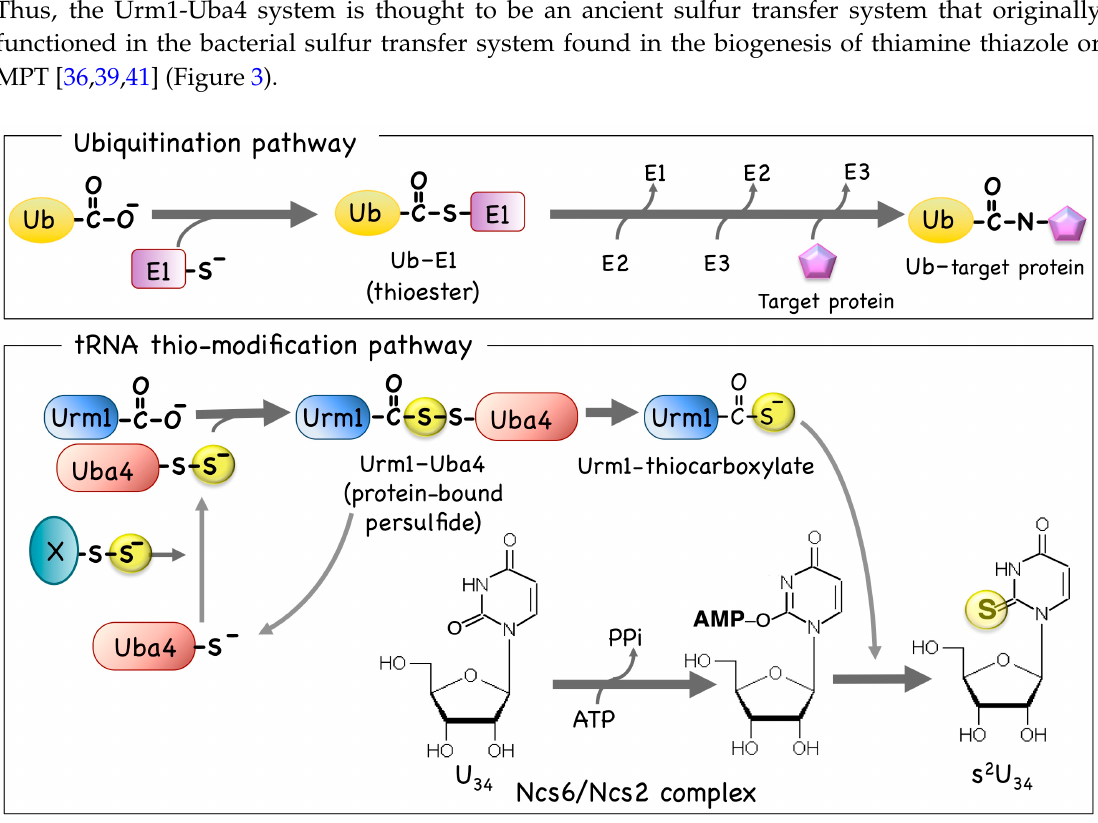
Figure 3. The UBL—ubiquitin ‐ activating enzyme (E1) ‐ like protein system related to the thio-modification of cytosolic transfer RNA (tRNA). The protein modifier system of ubiquitination found in eukaryotes (upper column) is compared with a plausible model for the sulfur transfer between Uba4 and Urm1, which is for the s 2 U 34 formation in yeast cytosolic tRNA (lower column). In the ubiquitination pathway, ubiquitin (Ub) is first bound to the UBA protein E1 (a sulfhydryl of an active cysteine residue is shown in a yellow circle) and then, after several reactions, is finally bound to form a thioester bond. In the thio-modification pathway, a UBL protein Urm1 is first bound to the partner UBA protein, Uba4. A complex of Ncs6 and Ncs2 (the Ncs6/Ncs2 complex) is thought to be involved in the last step of the tRNA recognition and thio-modification of cy-tRNAs. Sulfur atoms transferred in this system are shown with filled circles.